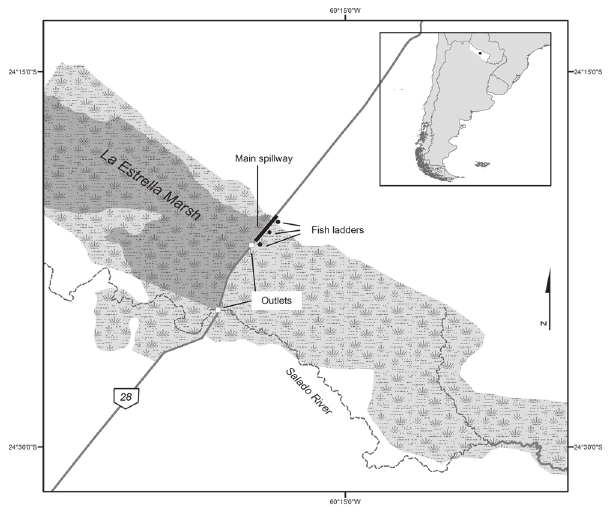
Fig.1 . Location of La Estrella marsh- Route 28 Dam complex in Formosa Province,